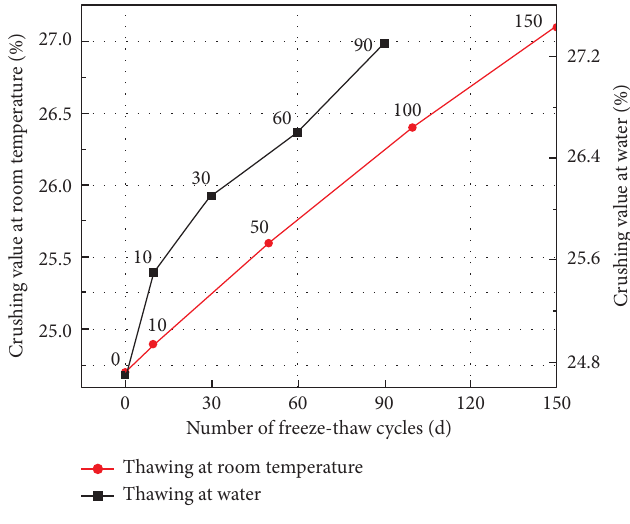
Figure 7: Crushing value of FSW after freeze-thaw. Table 5: Resilience modulus of FSW in different